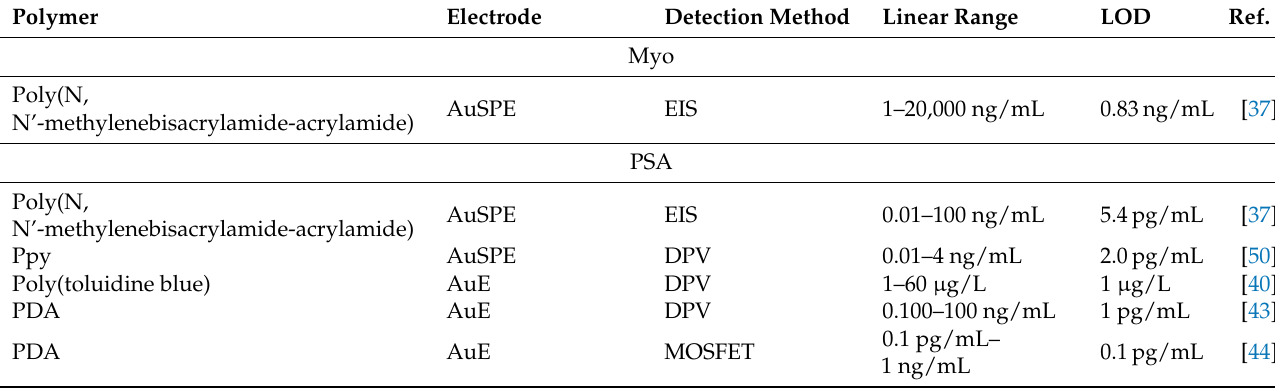
Table 2. The summary of MIP application for detection of cancer